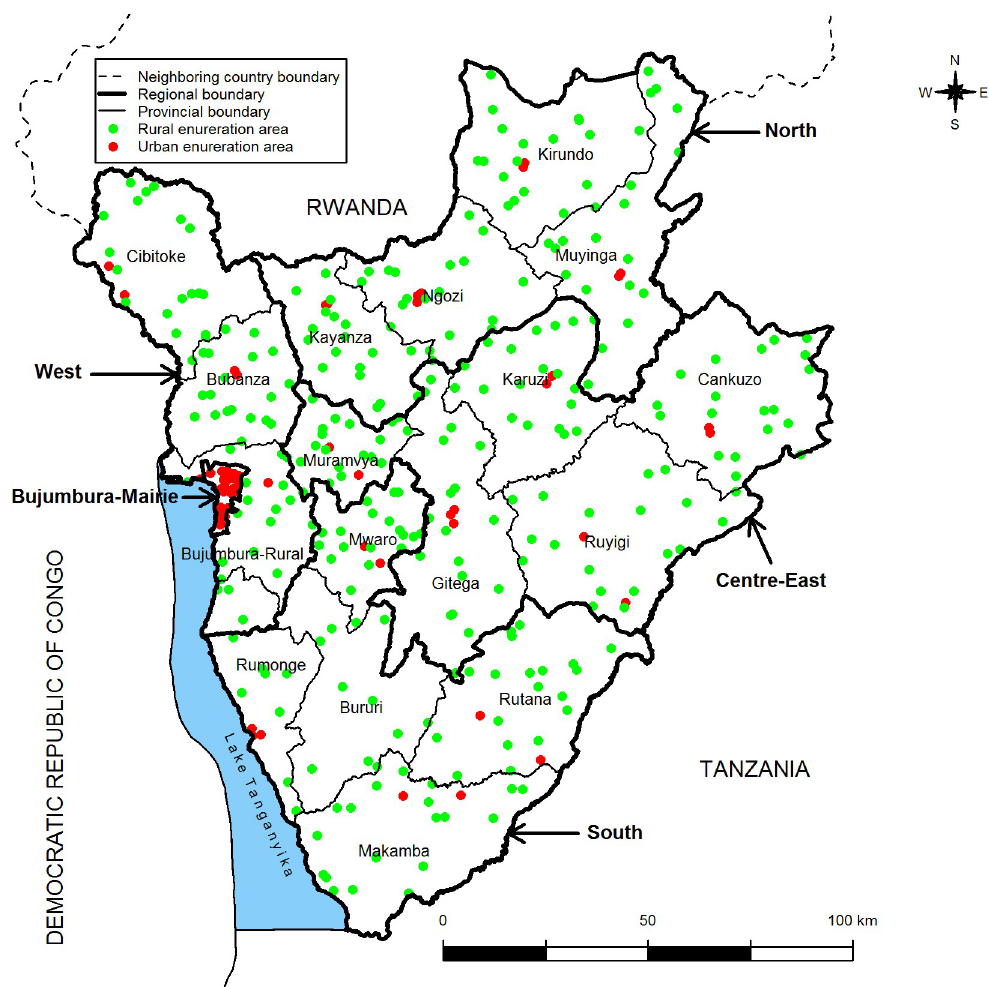
Fig 1. Spatial distribution of